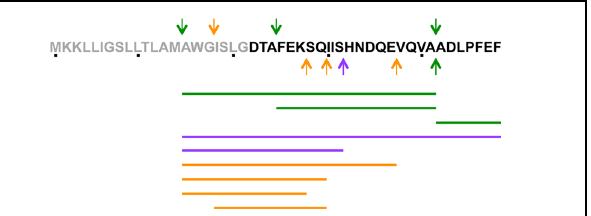
FIGURE 4 | Schematic representation of the presence of PapR-derived peptides in the supernatant of Bt (cid:2) codY compared to the wild-type strain. The culture supernatant of (cid:2) codY and wild-type cells was filter-sterilized before concentration and injection in an LTQ-Orbitrap for LCMS/MS analysis. Cells were grown in synthetic broth + glucose at 37 ◦ C. Samples were collected 0.5 h after entry into stationary phase. The arrows on the PapR peptide sequence indicate the main cleavage sites (in N-terminus, above the sequence and in C-terminus, below the sequence) deduced from the peptides found in the supernatant of both strains. The lines below the peptidic sequence schematize the peptides found in the supernatants. Green refers to cleavage sites and peptides common to (cid:2) codY and wild-type, purple are specific to wild-type and orange to (cid:2) codY